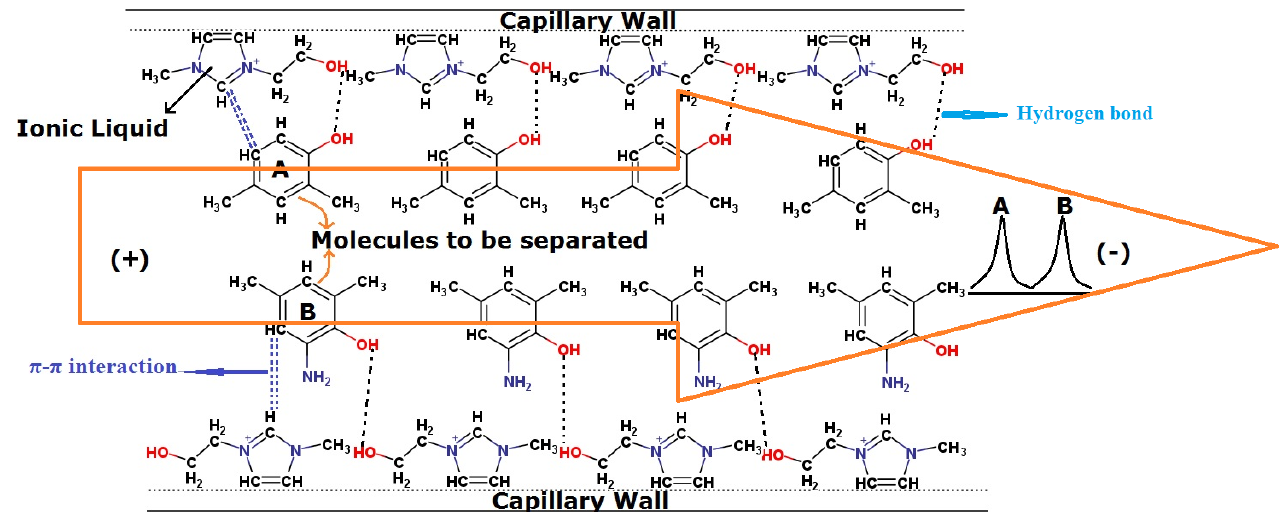
Figure 5. Schematic representation of separation in capillary electrophoresis with ionic liquids, A and B are analytes.